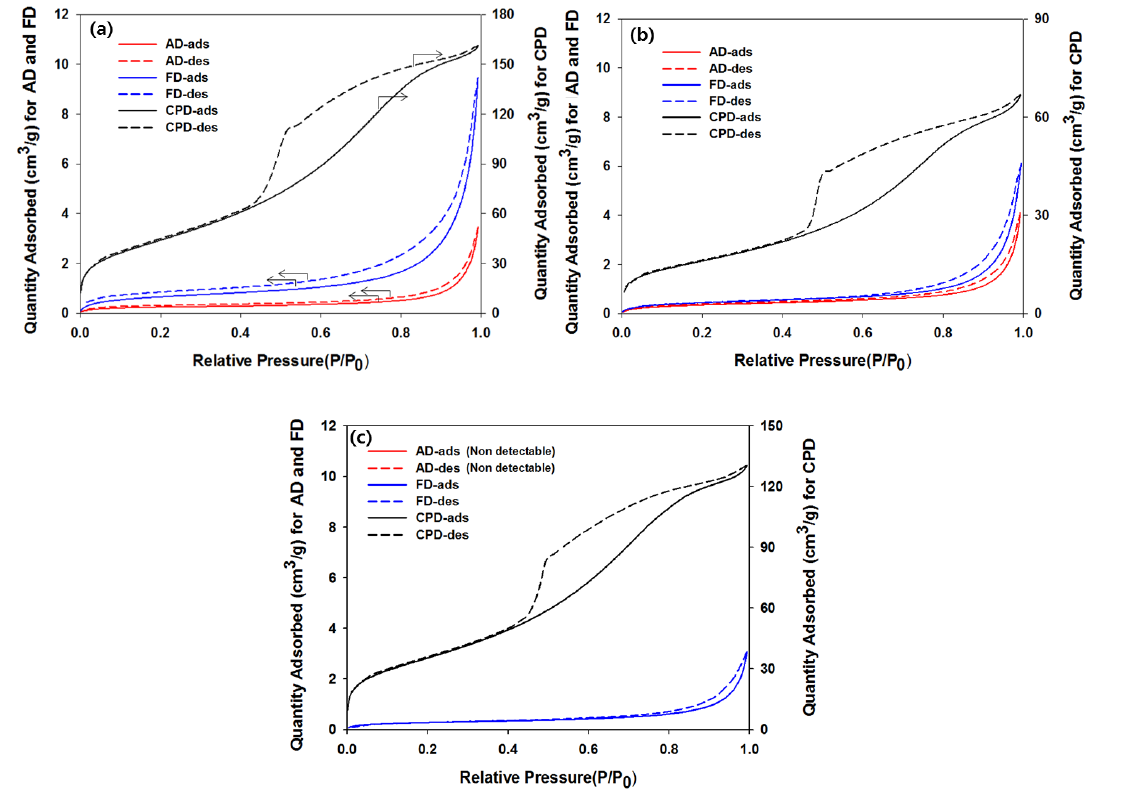
Figure 1. Nitrogen adsorption–desorption isotherms for air (AD), freeze (FD), and critical point (CPD) dried Eucalyptus samples with ( a ) ALEW, ( b ) 1% H 2 SO 4 , and ( c ) NaOH–steam pretreatments.